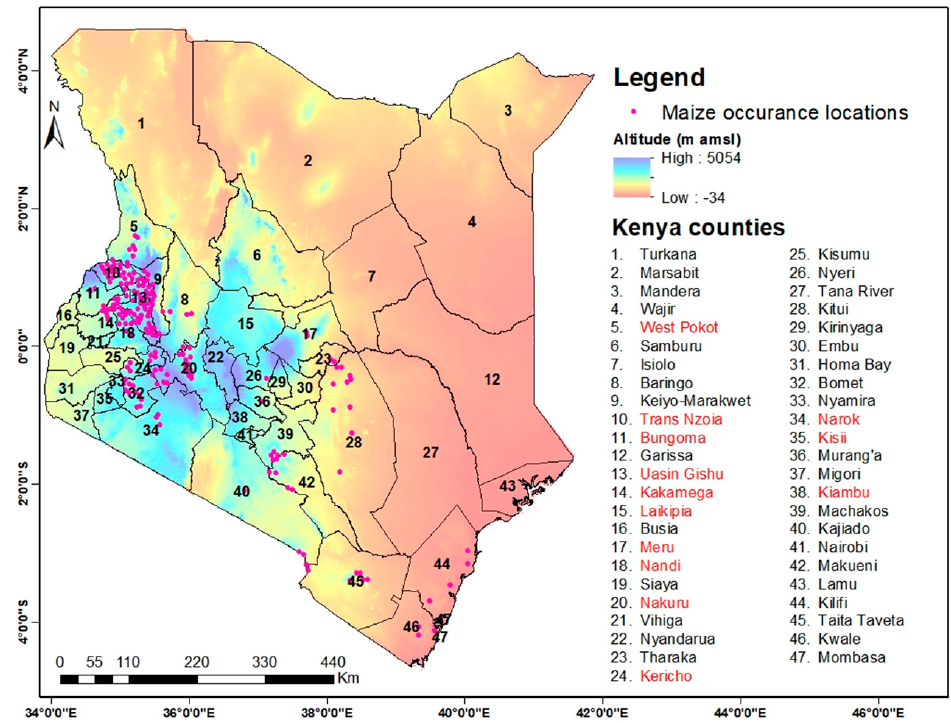
Figure 2. Distribution of maize production occurrence sites selected for training the MaxENT model; included are the altitude and the counties in Kenya. The key maize growing locations are highlighted in the